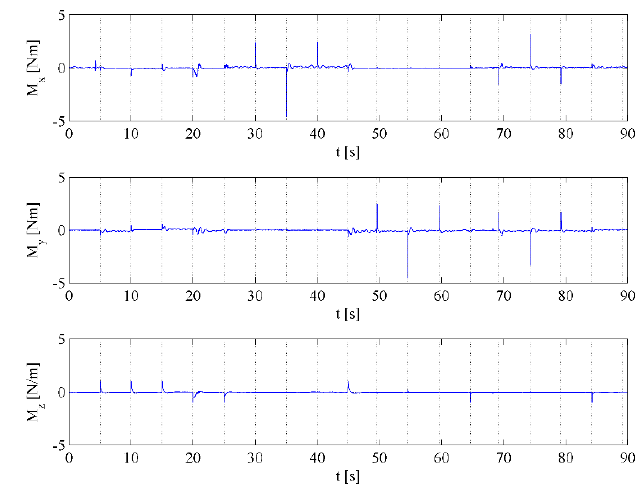
Figure 19. Desired torques of the quadrotor when using backstepping controller.